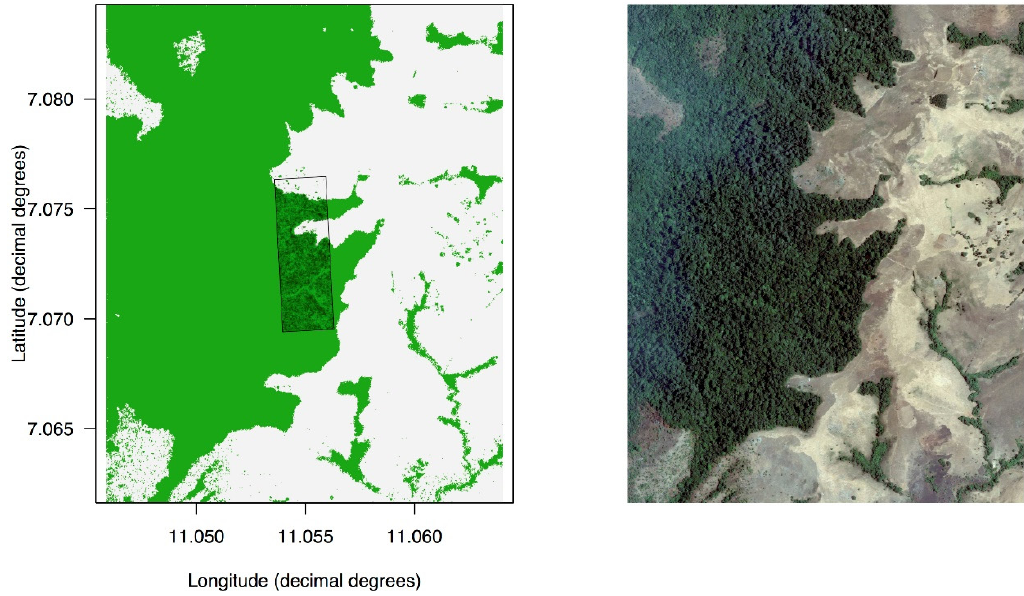
Figure 2. Vegetation mosaic in the Ngel Nyaki Forest Dynamics Plot (260 × 780 m) and surrounding areas. White pixels are grass, green pixels are forest. The location of the plot is shown by the black rectangle on the simplified vegetation map on the left ( A ). For the purposes of this study, “grass” was defined as pixels with red content 37% or more in a jpg image of the area taken from Google Earth, presented on the right ( B ). This 37% threshold was optimized to obtain the best possible correspondence between the aerial image and the binary map of the grass / forest boundary. Pixels are approximately 1 × 1 m, allowing for an individual tree-level resolution. This allowed the fine-tuning of the geolocation of the plot to obtain an almost perfect match between our individual tree map (trees within the plot) and the larger grass vs. forest